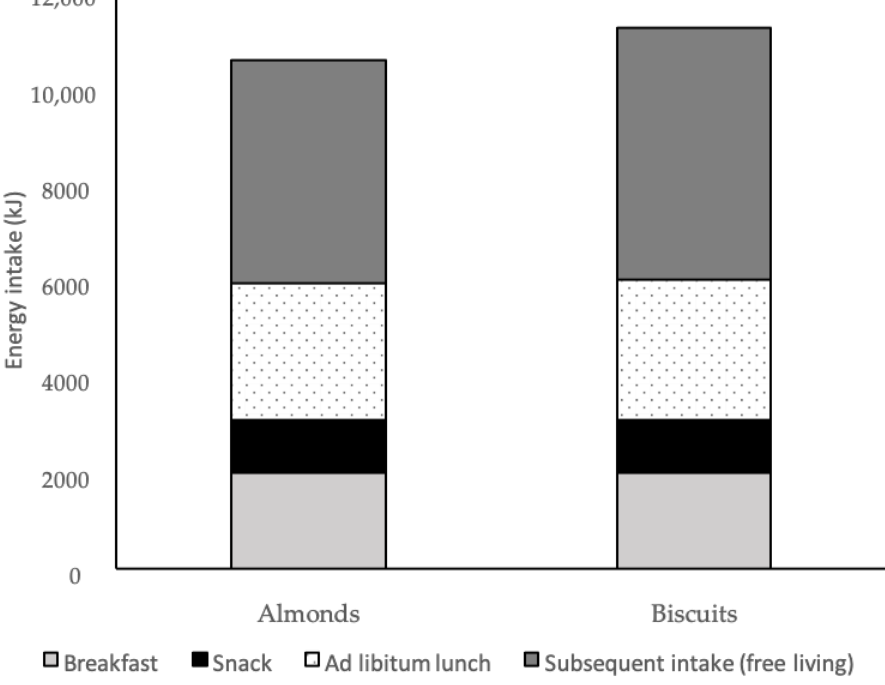
Figure 5. Mean energy intakes consumed during the standard breakfast (light grey bars), the standardised morning study snack (black bars), the ad libitum lunch (dotted bars) and subsequent intake for the remainder of the day (free living) (dark grey bars).